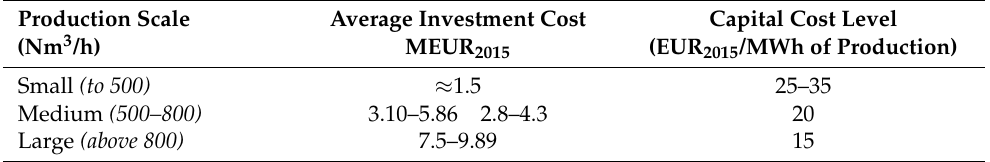
Table 6. AD plant investment and capital cost level concerning the production scale of biomethane. Production Scale